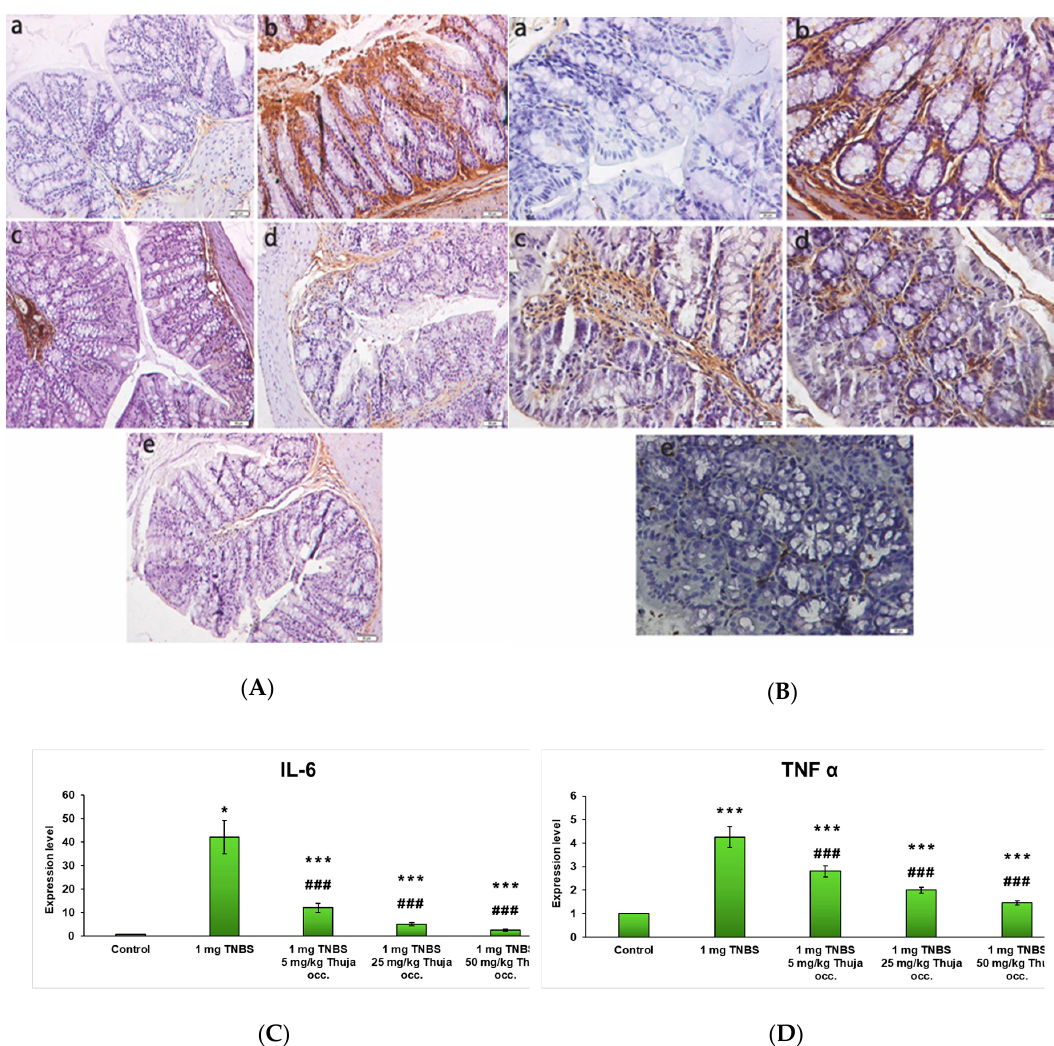
Figure 6. Immunohistochemical expression of IL-6 ( A ) and TNF α ( B ) in the intestinal mucosa for experimental groups: ( a ) Control; ( b ) TNBS; ( c ) TNBS + 5 mg Thuja occidentalis MT / kg of body weight; ( d ) TNBS + 25 mg Thuja occidentalis MT / kg of body weight; ( e ) TNBS + 50 mg Thuja occidentalis MT / kg of body weight. Magnification at 20 × ( a ) and 50 × ( b , c ). Gene expression of interleukin-6 (IL-6) ( C ) and tumor necrosis factor-alpha (TNF- α ) ( D ) inflammation markers in the experimental groups. Note: *** p < 0.001 versus control; ### p < 0.001 versus TNBS group.